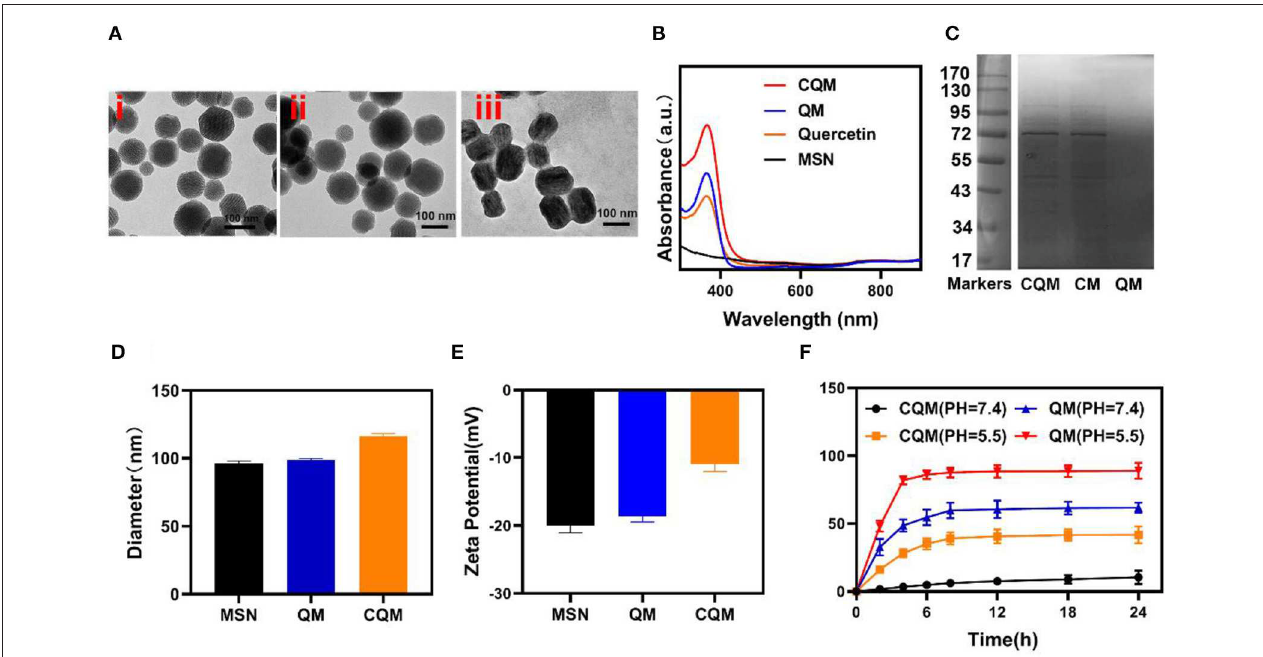
FIGURE 1 | Characterization of CQM nanoparticles. (A) TEM image of (i) MSNs, (ii) QM, and (iii) CQM. (B) Absorbance spectra of CQM, QM, QT, and MSNs. (C) SDS-PAGE protein analysis of CQM, CM, and QM. (D) Hydrodynamic diameter and (E) Zeta potential of MSN, QM, and CQM. (F) QT release profiles under different